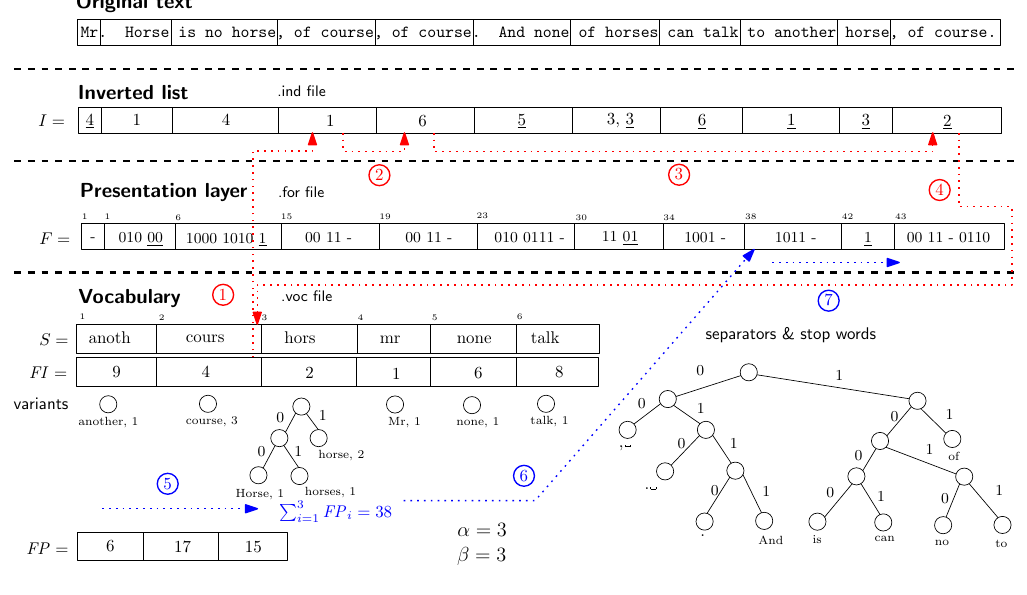
Figure 1. Positional Inverted Self-Index ( PISI ) data structure: The original text is divided into single entries each of them containing exactly one stem (disregarding stop words and separators). The underscored values in the Inverted list represent the back pointers to the Vocabulary. The underscored bits in the Presentation layer represent Huffman codewords of stem variants. The coloured dotted lines refer to Example